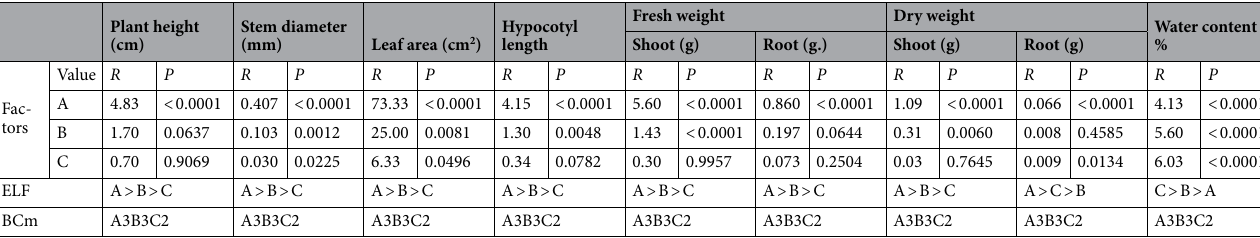
Table 1. Results of the range and ANOVA of the L9 (3 3 ) matrix for the influence of combined, irradiances of LEDs light (Factor A), light spectral ratios (Factor B), and photoperiod (Factor C) on growth characteristics of cucumber seedlings.